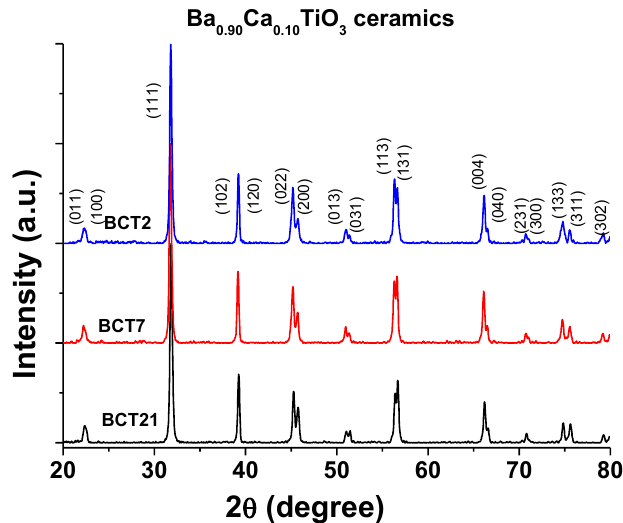
Figure 1. Room temperature XRD of a few selected BCT ceramics.